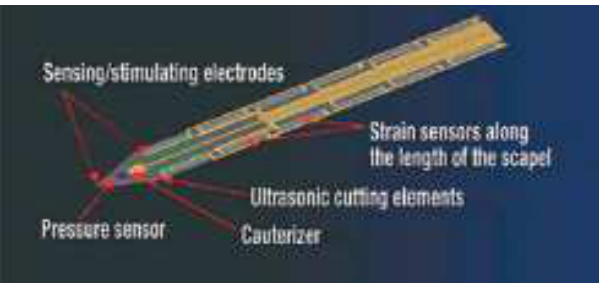
Figure 6 . Surgical knife developed by Verimetra